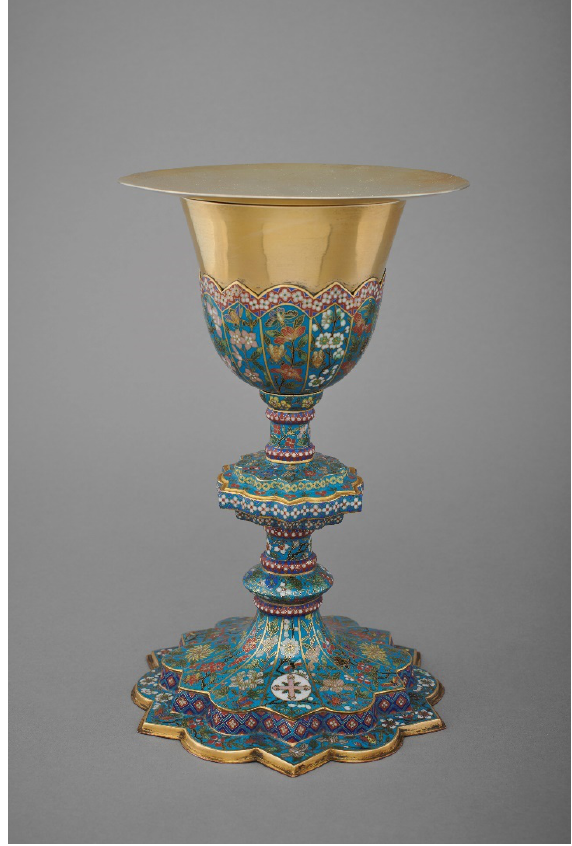
Figure 4. Chalice of Figure 3. Photo: Conseil départemental de l’Orne/Thierry Ollivier.